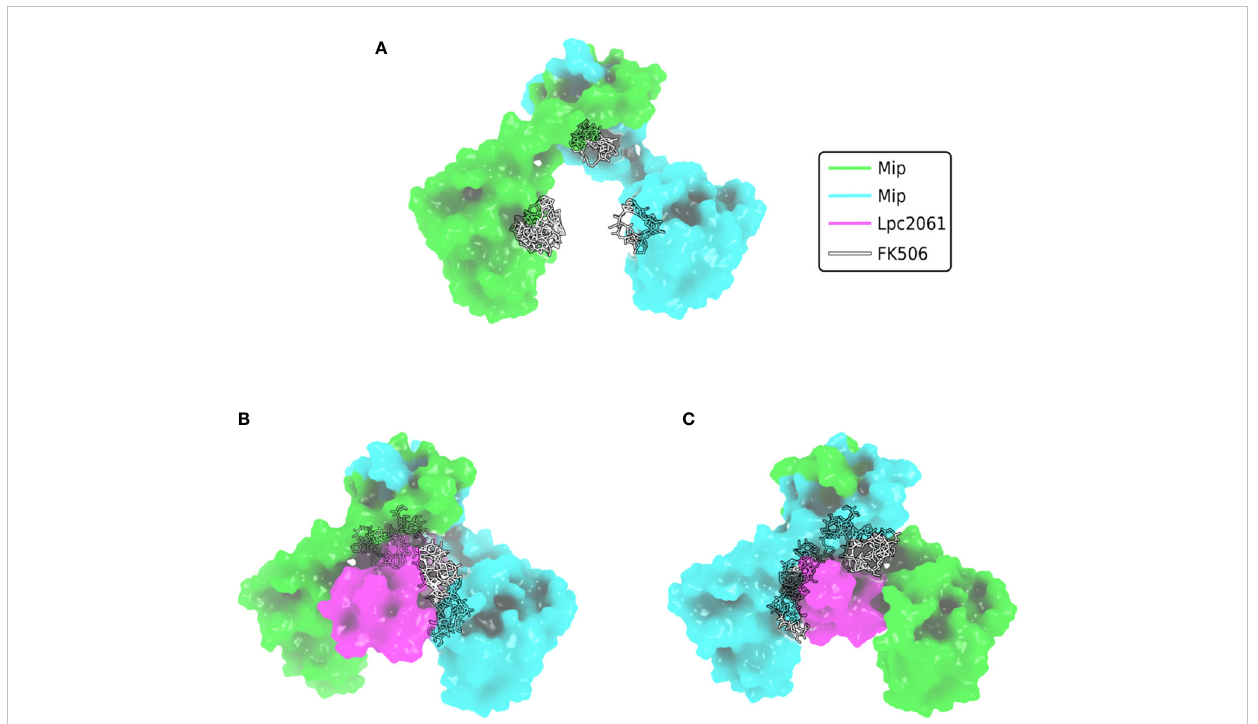
FIGURE 5 Docking of FK506 to Mip and competitive inhibition of Lpc2061 binding. (A) Docking of FK506 (grey) to the Mip homodimer (green and cyan) results in binding to the dimerization and the two PPIase domains. (B) Lpc2061 (magenta) binding to Mip is inhibited by FK506, since the inhibitor blocks this triangle. (C) Overlapping binding regions of Lpc2061 and FK506 after rotation by 180°. Molecular docking was performed using DiffDock (Corso et al.,